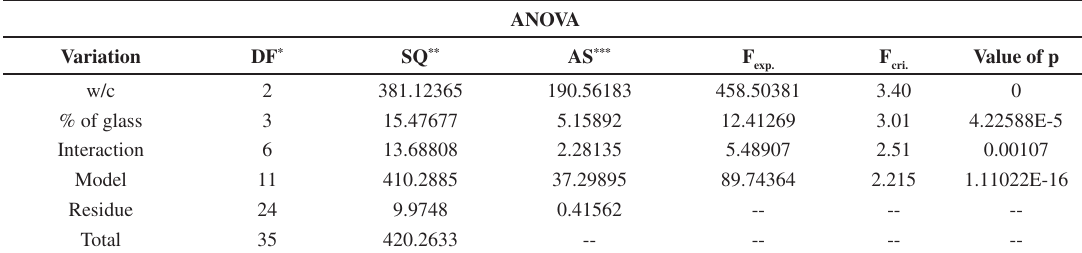
Table 3. ANOVA values of the compressive strength test to determine the effects of the w/c ratio and waste glass percentage after 7 days of